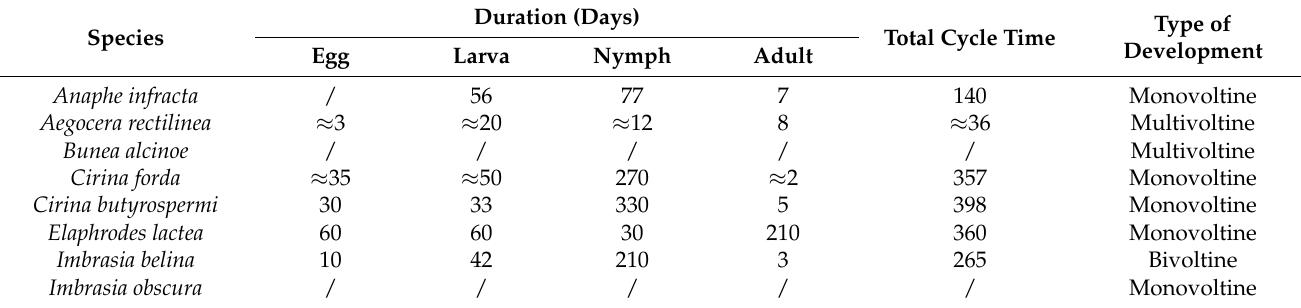
Table 2. Life cycle of Lepidoptera for which the larvae are consumed in